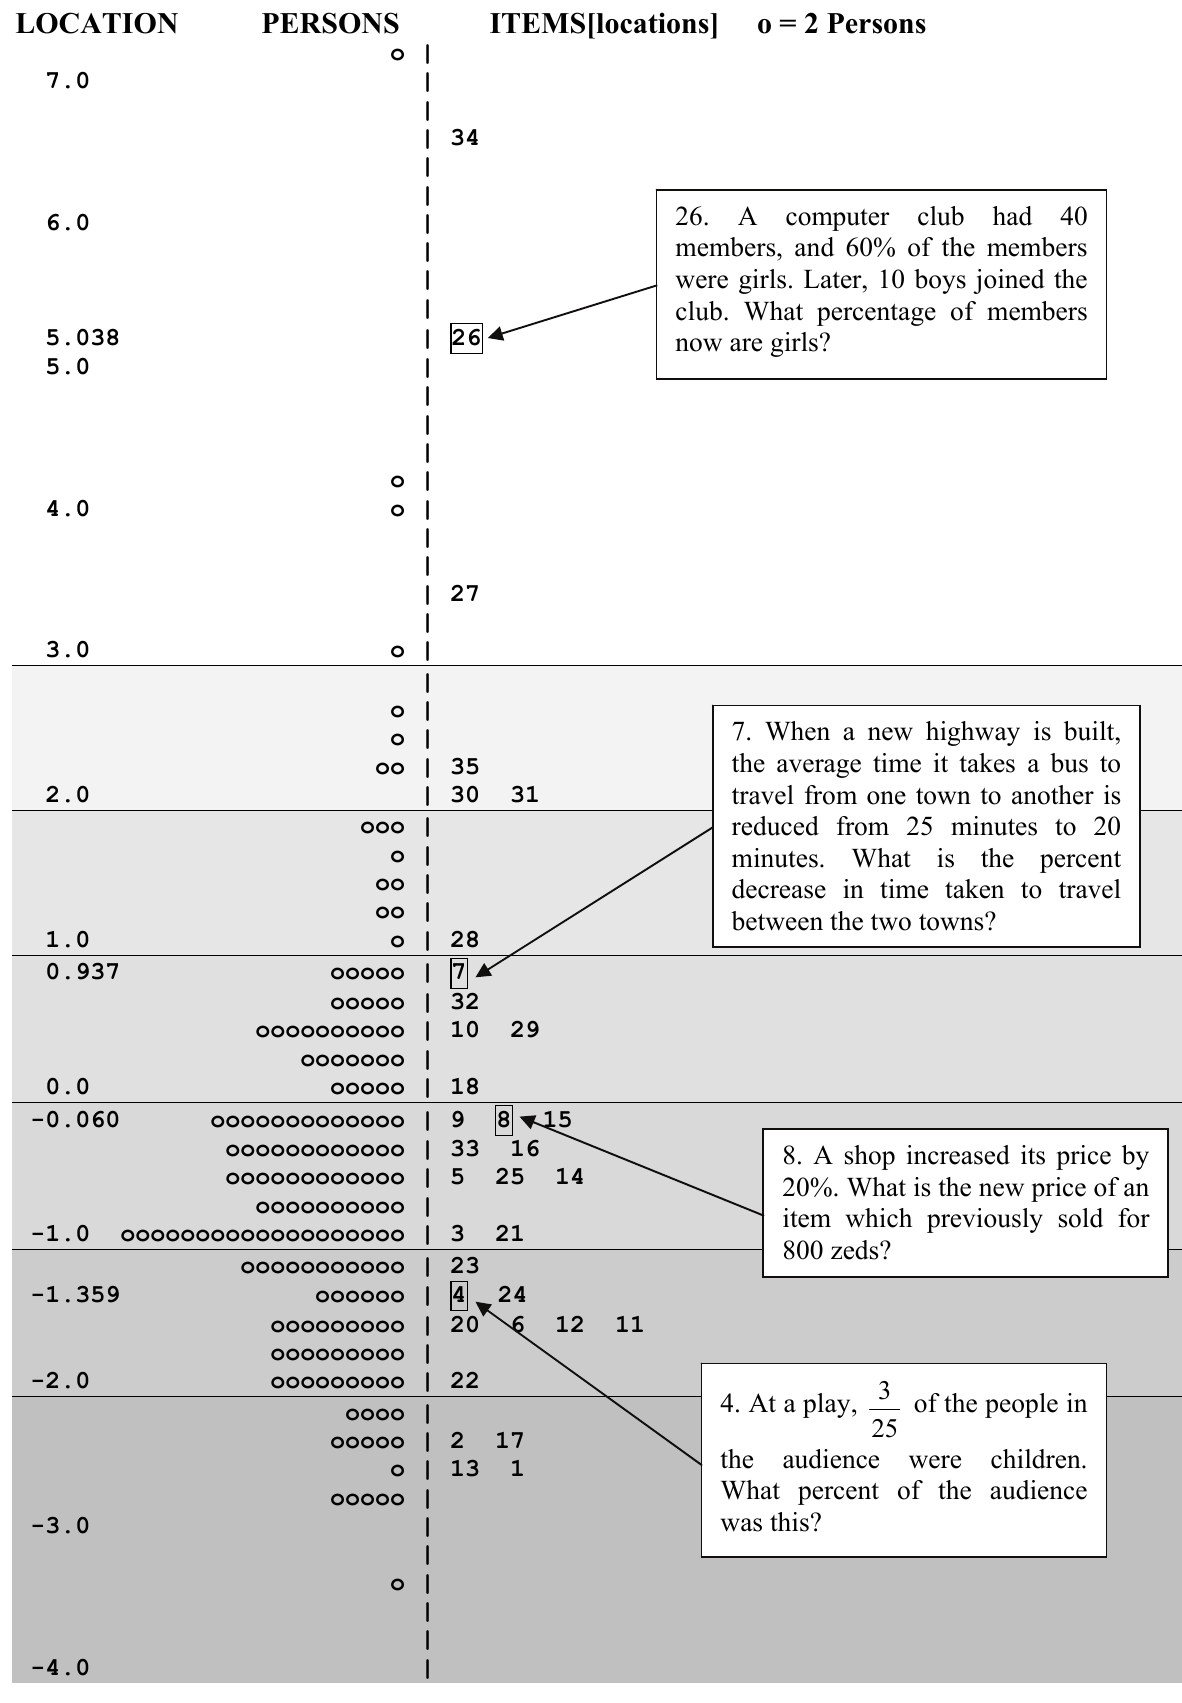
Figure 1 : Person-item location